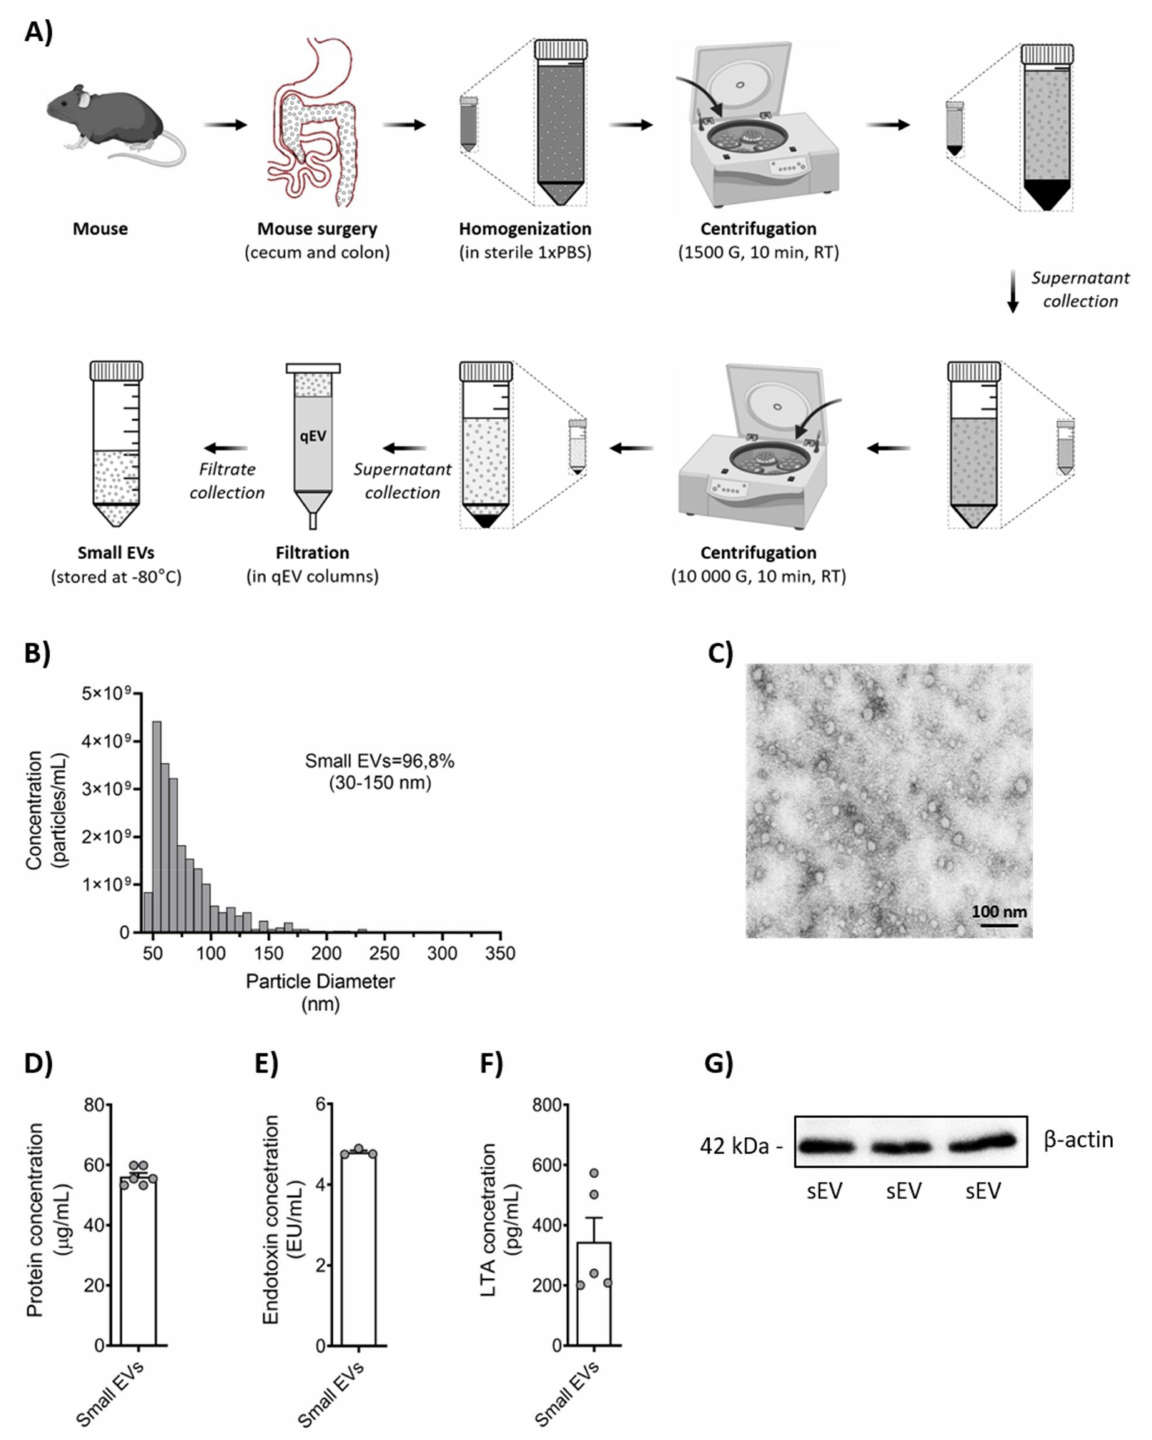
Figure 1. Schematic illustration of the isolation and purification process of small EVs from murine stool and their characterization. ( A ) Small EVs (sEV) isolated from the stool of mice from cecum and colon using qEV columns. Analysis of sEV concentration and their size distribution were determined by TRPS and TEM ( B , C ). Total protein concentration ( D ) was determined using the Pierce™ 660 nm Protein Assay Kit. Determination of endotoxin amount ( E ) was performed by Pierce LAL Chromogenic Endotoxin Quantification kit assay, whereas the amount of LTA ( F ) was measured by Mouse lipoteichoic acids (LTA) ELISA Kit. Protein expression of β -actin ( G ) was analyzed by Western blotting. Data are shown as scatter dot plots, mean + SEM (repeated